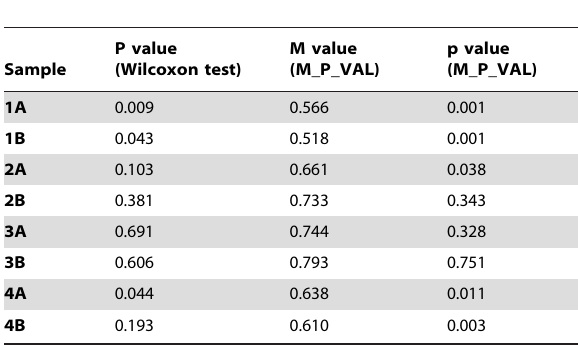
Table 7. Results of the bottleneck